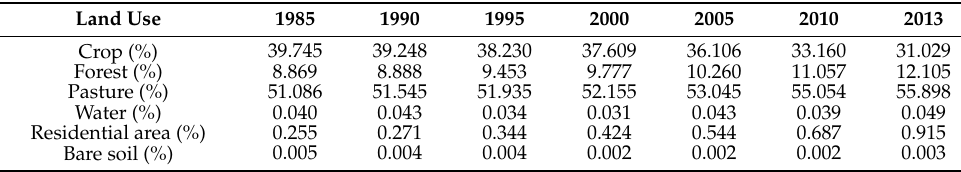
Table 1. Statistics of land use areas in the JRB during 1985–2013.